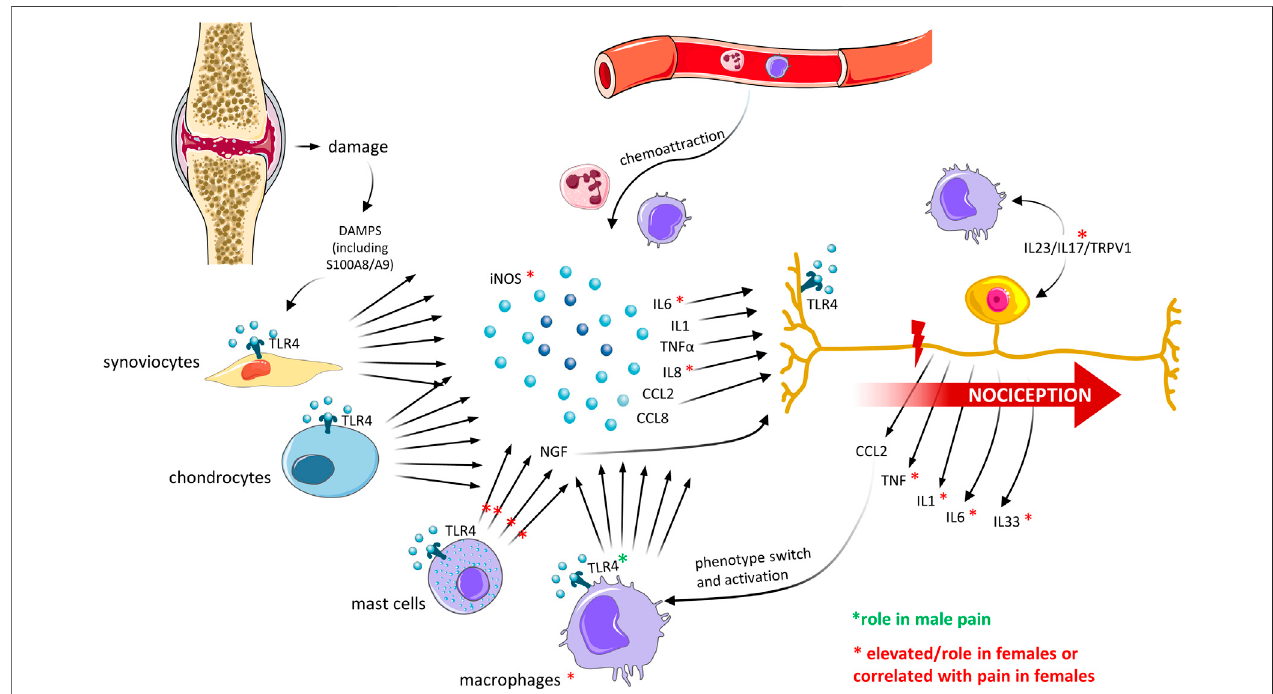
FIGURE3| SexdifferencesininnateimmunemediatorsinthejointandcrosstalkwithOApain.RecentOApreclinicalandclinicalstudieshavedescribeddifferences in the expression of mediators of the innate immune system, which correlated with differences in pain perception between men and women. The major fi ndings are described. Created with Smart. Servier ®